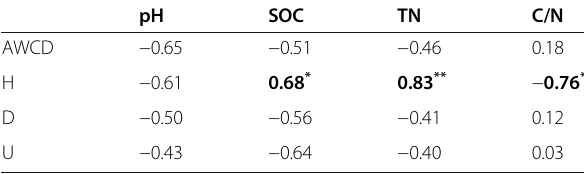
Table 3 Correlation coefficients between soil physicochemical properties and soil microbial functional diversities